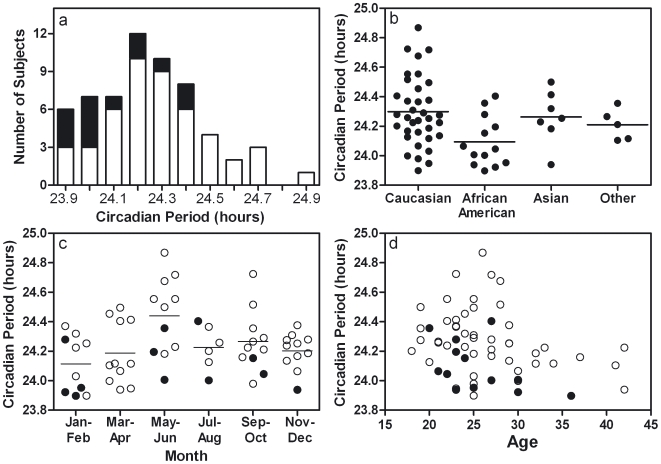
Racial differences in the human endogenous circadian period.The human endogenous circadian period depends on race, season, and age. (a) Histogram of circadian period (tau) for subjects (n = 60) whose self-reported race was African American (black bars) or not African American (white bars). (b) Circadian period by self-reported race. (c) Circadian period by 2 month bins. In (b) and (c), horizontal lines depict the mean. (d) Circadian period by age. Black dots in (c) and (d) indicate African American subjects.